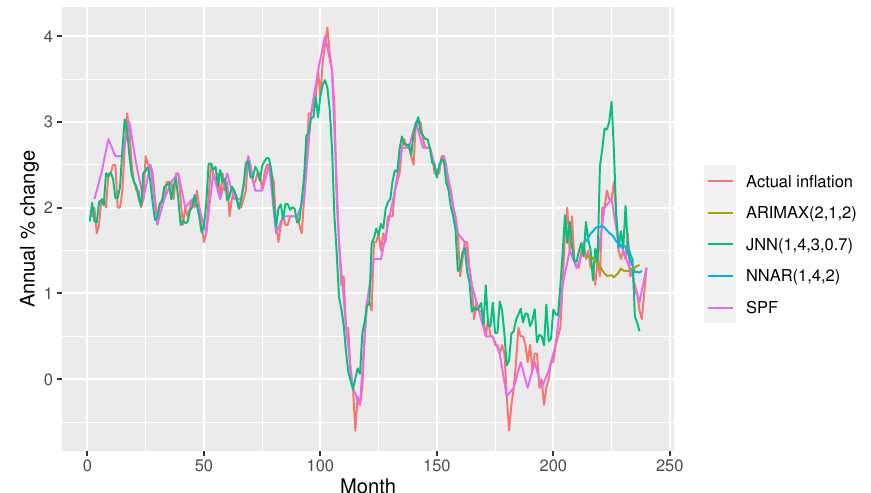
Figure 2. Forecasts comparison without exogenous inputs.